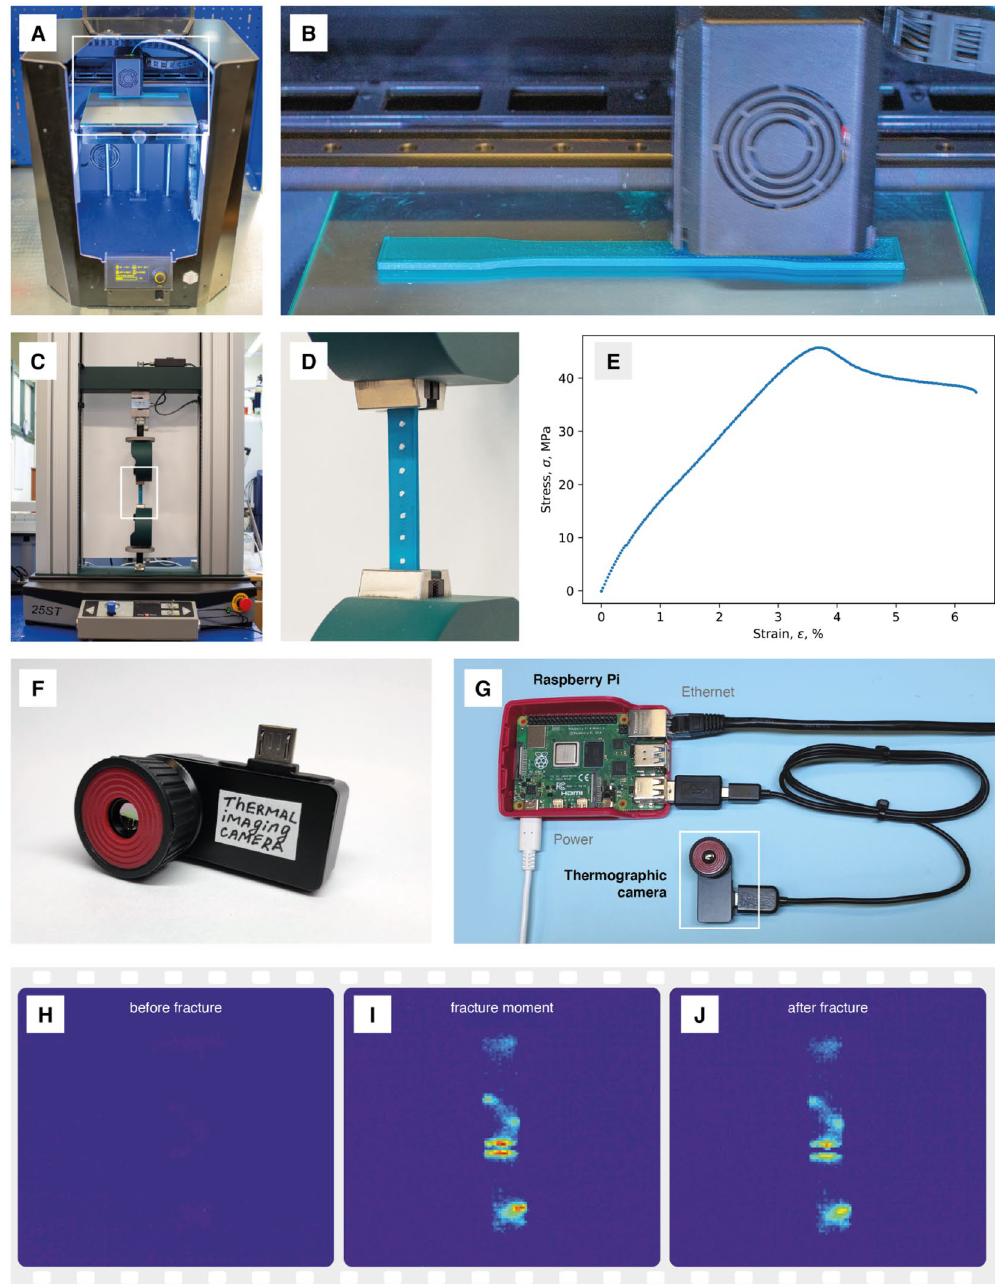
Figure 2. Overview of the approach for 3D printing, tensile and thermal analysis, and data acquisition. ( A ) Desktop FDM 3D printer Picaso X-Pro used for plastic specimens printing; ( B ) printing process of one of the plastic specimens; ( C ) general view of the universal testing machine Tinius Olsen 25ST used for tests of tensile strength; ( D ) one of the plastic specimens clamped in the grips of the machine and dotted for strain analysis; ( E ) stress–strain curve for one of the specimens; ( F ) Seek Thermal Compact Pro infrared camera for thermographic analysis of the destruction process; ( G ) infrared camera connected to Raspberry Pi compact computer for data collection and transfer; ( H – J ) thermograms of the plastic specimen during the tensile test: ( H ) before destruction, ( I ) destruction moment and ( J ) after